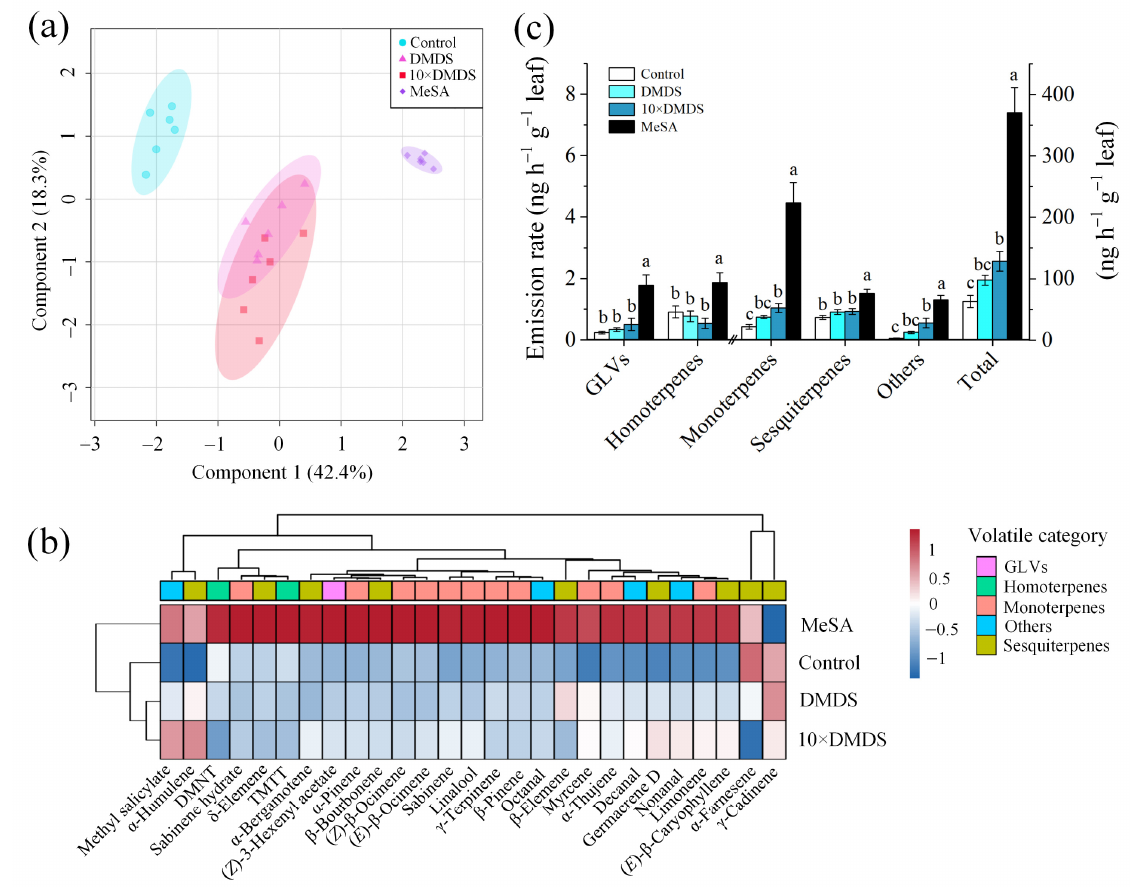
Figure 6. Volatile profiling of orange plants after exposure to dimethyl disulfide (DMDS). ( a ) PLS- DA (score plot); and ( b ) clustering analysis and heat map (average) of orange volatile metabolites. ( c ) Emission of orange volatiles from different classifications. Data are shown as means ± SE ( n = 6). Different letters on the columns indicate significant differences among different treatments based on Tukey’s test ( p < 0.05).